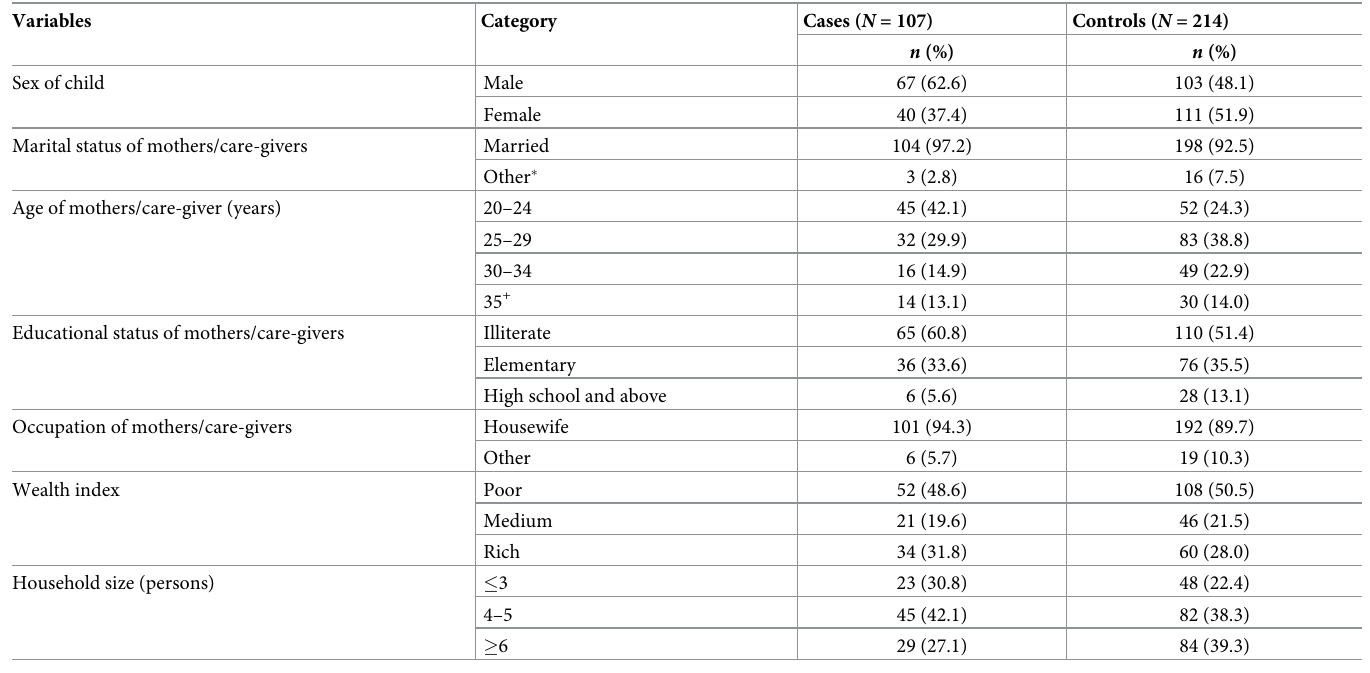
Table 1. Socio-demographic characteristics of children aged 6–59 months in Kemissie City Administration, northeastern Ethiopia, January to April